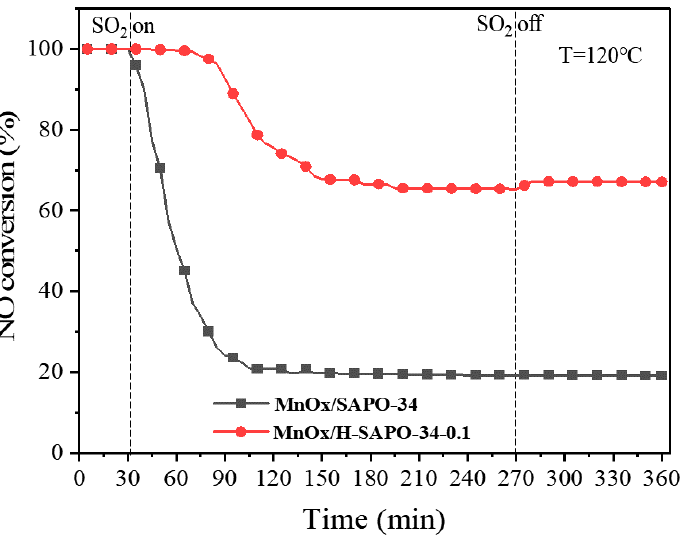
Figure 13. SO 2 tolerance of MnO x /SAPO-34 and Mn/H-SAPO-34-0.1 in NH 3 -SCR reaction. Reaction conditions: 800 ppm NH 3 , 800 ppm NO, 100 ppm SO 2 (when needed), 5 vol.% O 2 , Ar to balance, T = 120 °C, gas hourly space velocity (GHSV) = 40,000 h − 1 .